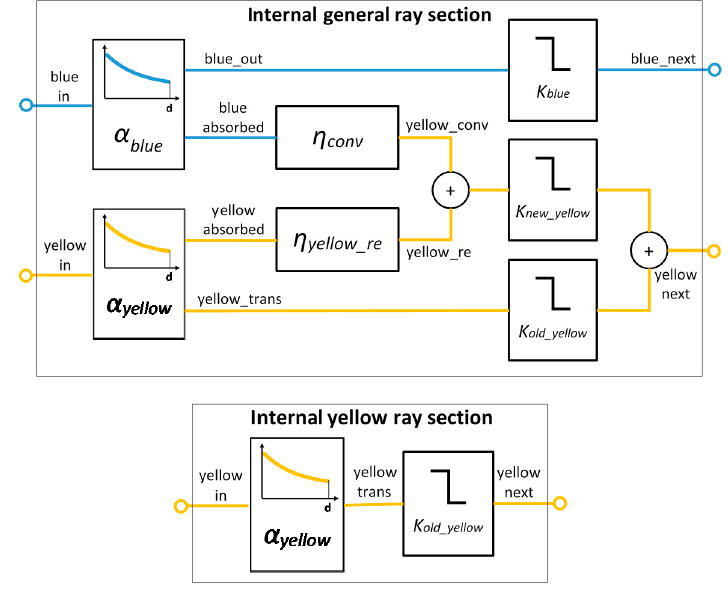
Figure 20. Structure of the internal ray sections.